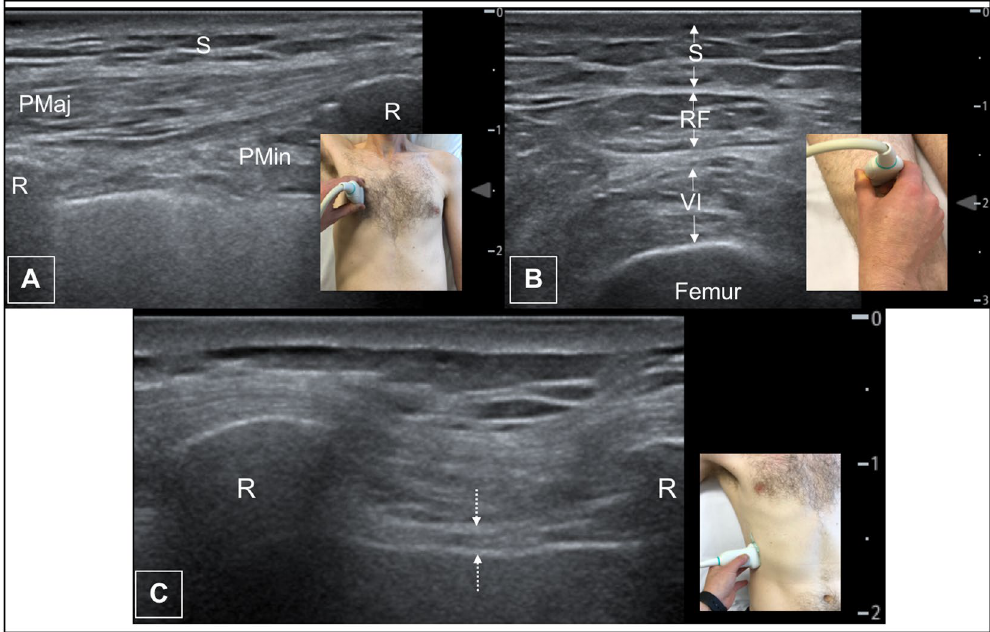
Figure 2. Pectoralis major, femoral muscle and diaphragm ultrasound images. ( A ) Typical ultrasound image of pectoralis major. ( B ) Typical ultrasound image and probe position of femoral muscles. ( C ) Typical ultrasound image and probe position of diaphragm thickness. S – subcutaneous fat PMaj – pectoralis major. PMin – pectoralis minor R – rib RF – rectus femoris VI – vastus intermedius. Dotted arrow – diaphragmatic surface.